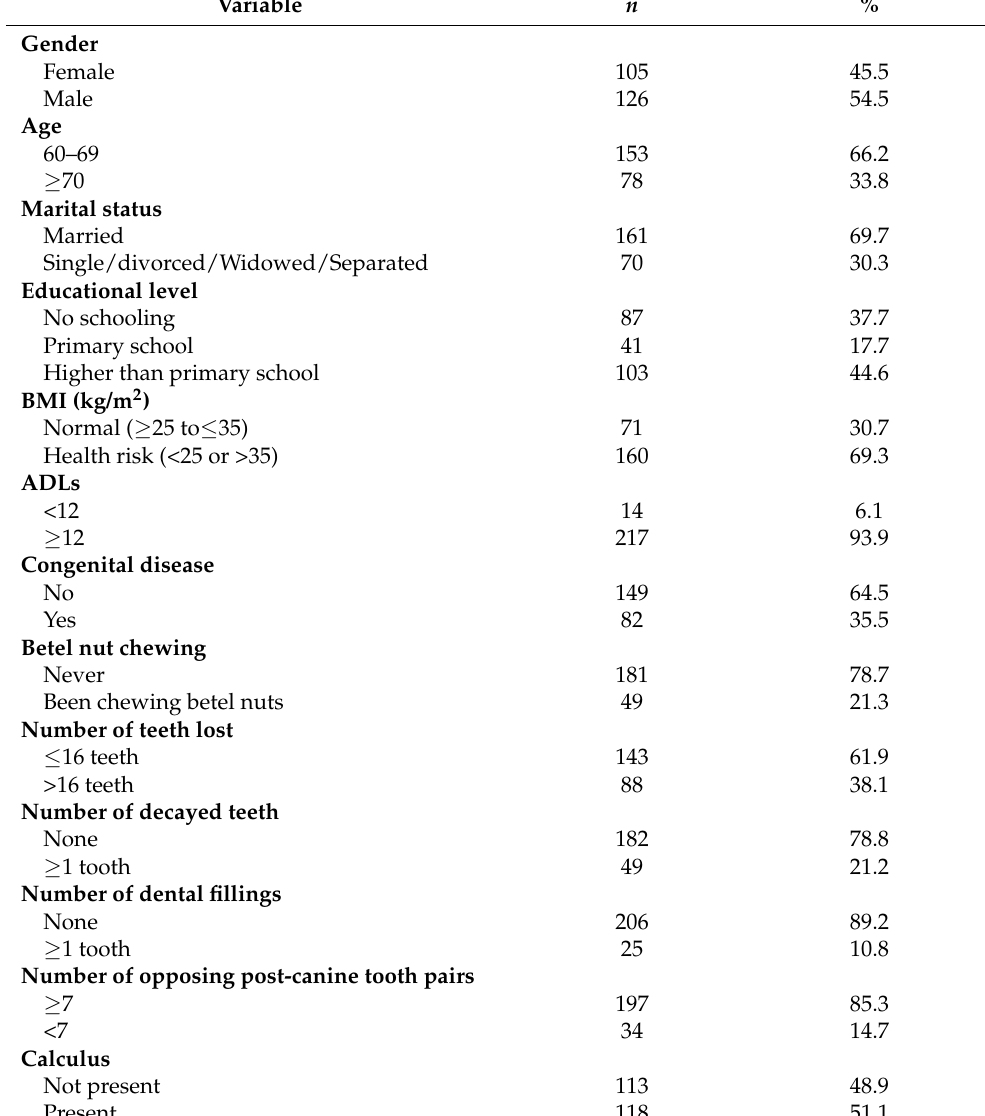
Table 1. Characteristics and dental status of participants ( N = 231).